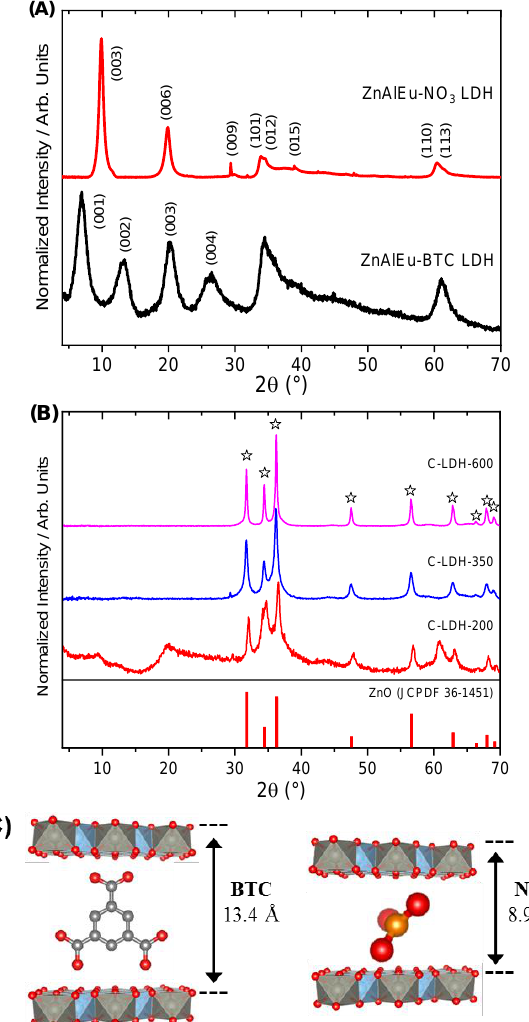
Figure 2. Powder X-ray diffraction patterns of ( A ) the as-prepared ZnAlEu LDHs and ( B ) ZnAlEu– NO 3 LDHs calcined at 200 °C (C-LDH-200), 350 °C (C-LDH-350), and 600 °C (C-LDH-600). Starred peaks are related to the formation of a ZnO-like phase. The diffractogram of ZnO is shown for comparison. ( C ) Intercalation scheme and basal spacing for LDHs with 1,3,5-benzenetricarboxilate (BTC) and NO 3− [30].